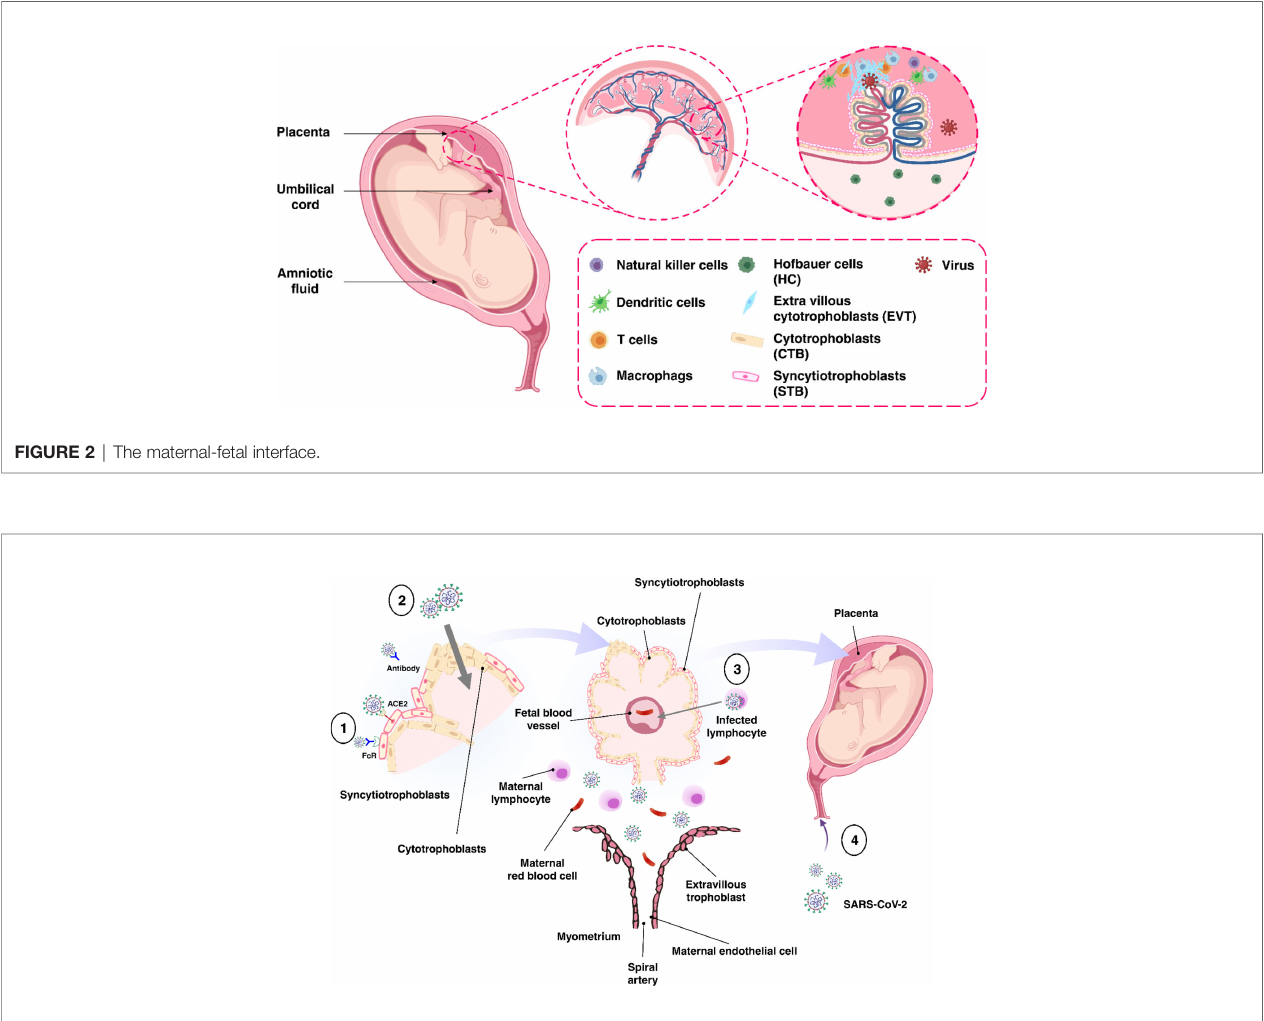
FIGURE 3 | Possible mechanisms of transplacental transmission. There are several potential mechanisms involved in the virus ’ s vertical transmission from mother to fetus. (1) Infection caused by direct villous tree damage. (2) Infection through the maternal endothelium to the extravillous trophoblast. (3) Infection caused by maternal immune cell traf fi cking and transcellular transport. (4) Infection through the vagina. Adapted from